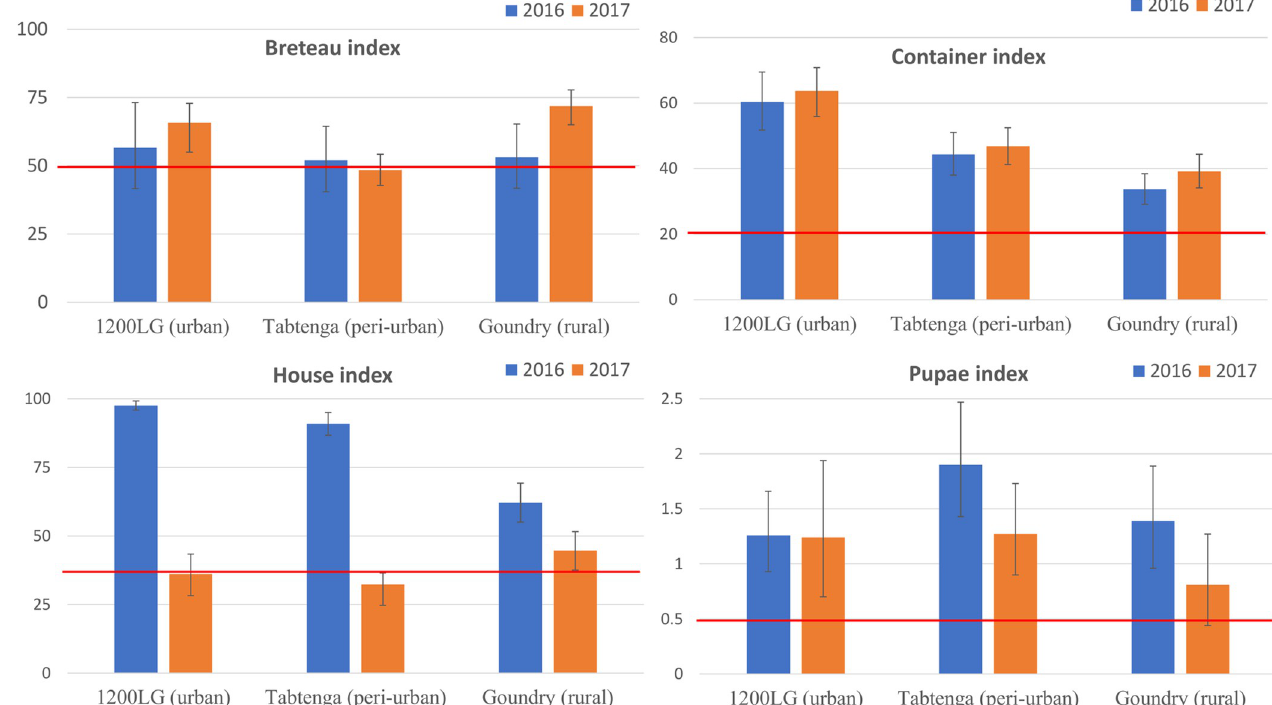
Fig 3. Breteau, container and houses indices (and 95% confidence intervals) and the number of pupae per person (PPI) (and 95% confidence limits) per year and per locality. The red line indicates the WHO thresholds that are set at 50, 20 and 35 respectively for BI, CI and HI. The PPI threshold is estimated based on an initial seroprevalence of 33% and an average temperature of 28˚C and for an increase of 10% of the seroprevalence